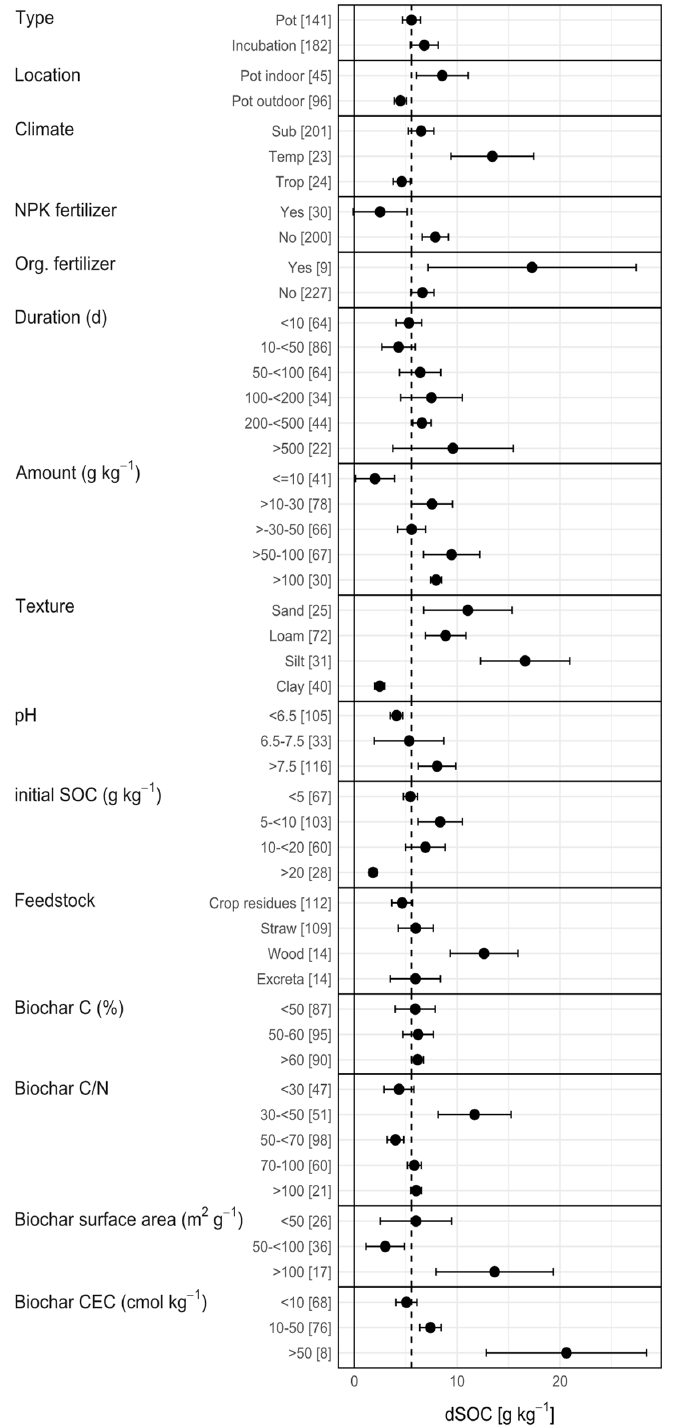
Figure 3. Meta-analysis results of the “non-field dataset”, given as a forest plot. Presented is the mean difference of soil organic carbon content after biochar application (dSOC) influenced by different data groups. Number in brackets represent the number of included treatments. Points within the range represent the mean dSOC and the line within the 95% confidence interval represents the range of the effect size. If the effect size range crosses the “zero-effect-line”, given as a solid vertical line at 0%, the result can be interpreted as statistically insignificant. The effect sizes of each group were considered to be significantly different at p < 0.05 from each other if the 95% confidence intervals were not overlapping. The vertical dotted line represents the grand overall